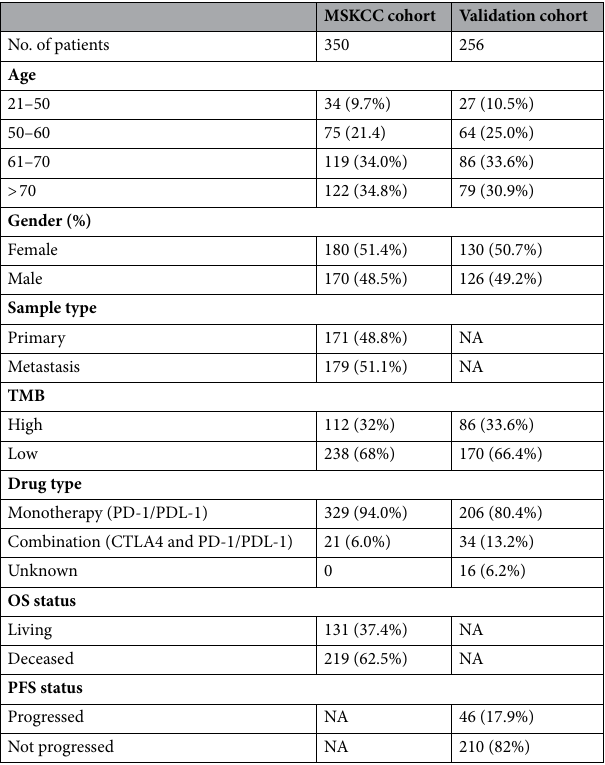
Table1. Clinical characteristics of the two immunotherapy